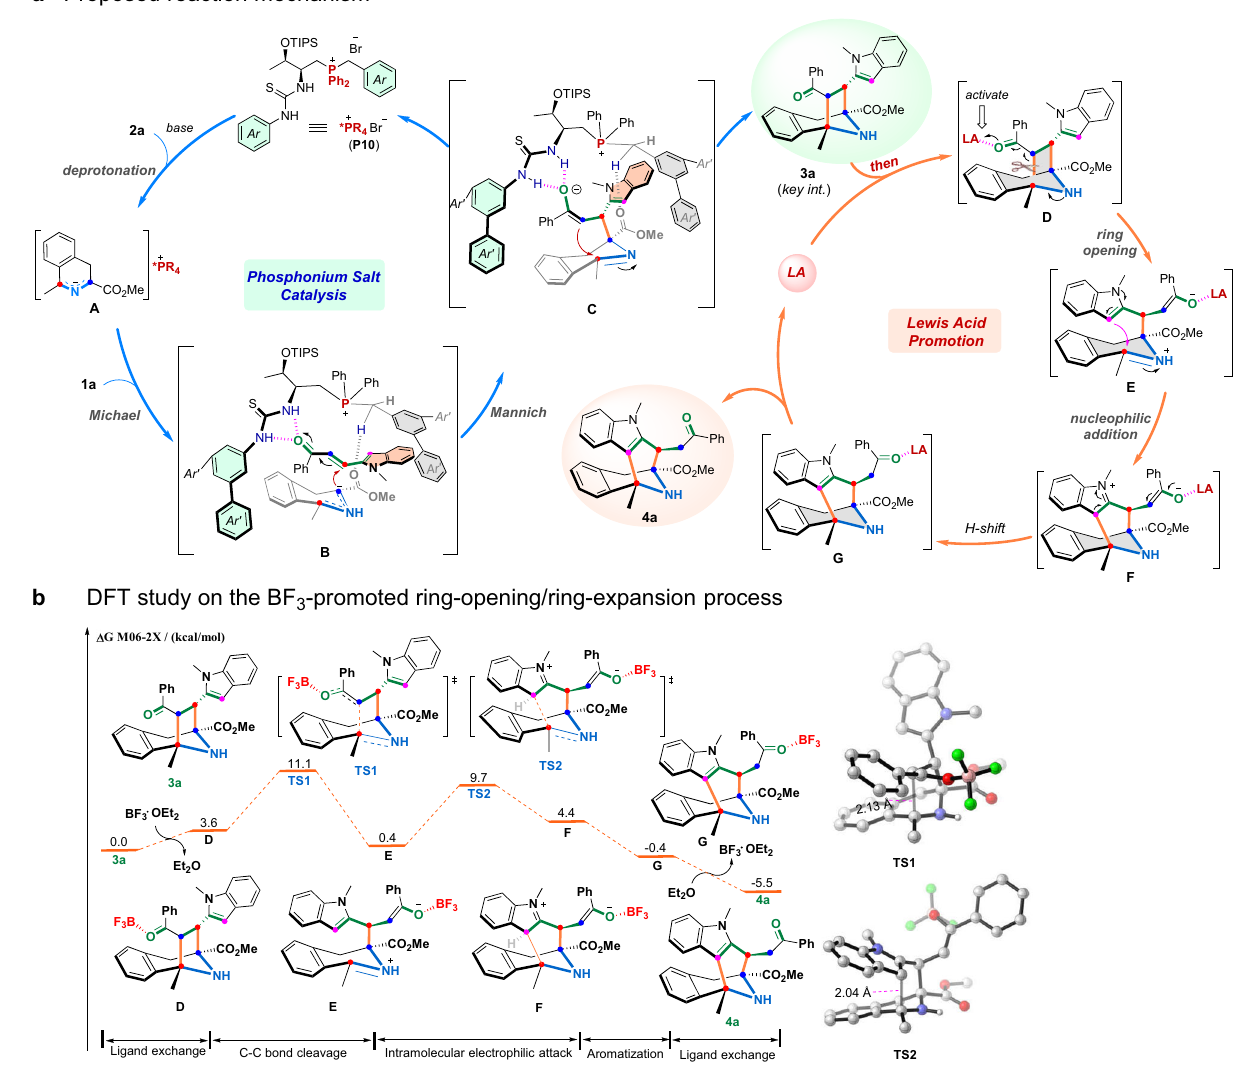
Fig. 8 Proposed reaction mechanism and DFT study. a Proposed reaction mechanism. b Free-energy pro fi les for the BF 3 -catalyzed ring-opening/ Friedel – Crafts cascade process. Energy values are given in kcal/mol. Bond lengths are given in